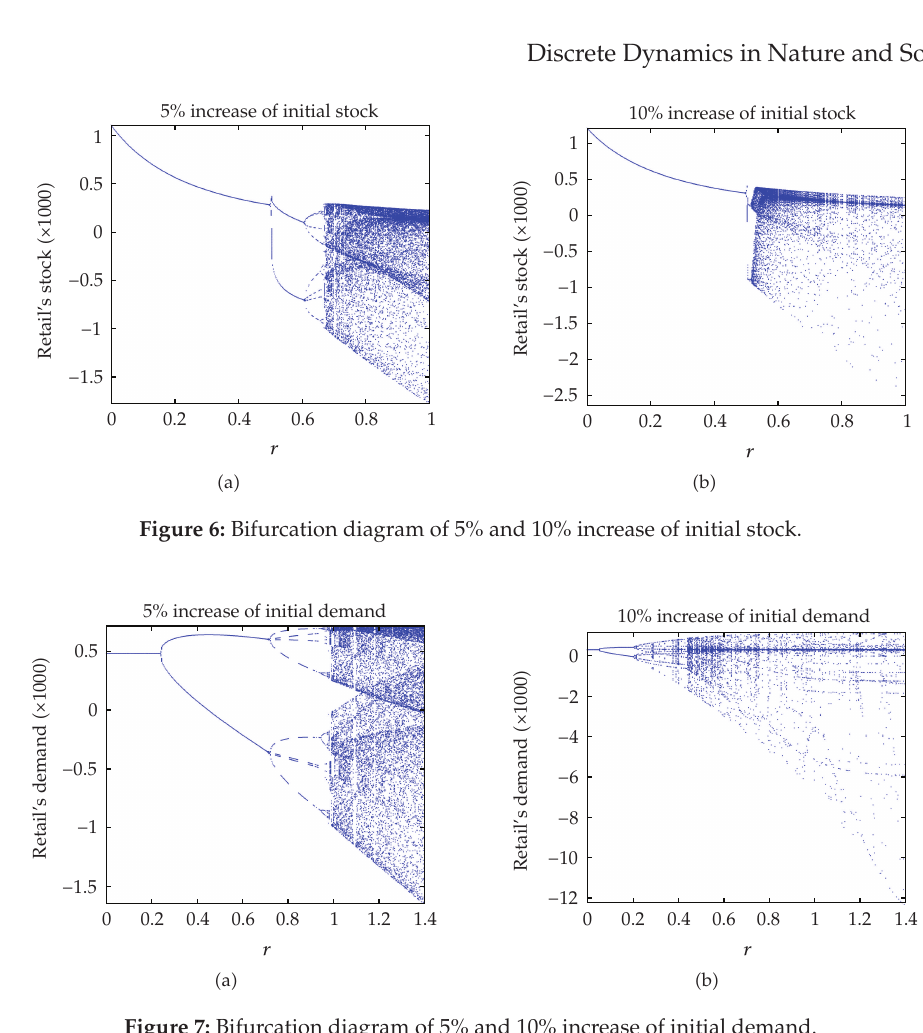
Figure 7: Bifurcation diagram of 5% and 10% increase of initial